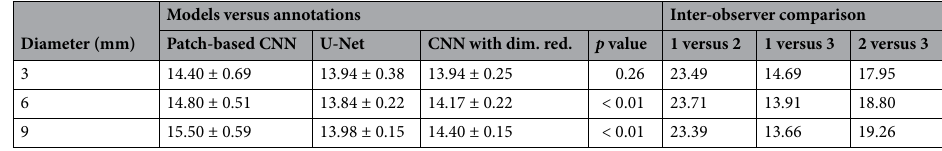
Table 1. Mean absolute error in μm of corneal thickness predictions on test set. Comparisons represent deep learning models versus annotations (left) and annotator versus annotator (right). Mean ± SD of 5 training repetitions. p values were calculated by one-way ANOVA and represent the chance that model performances are